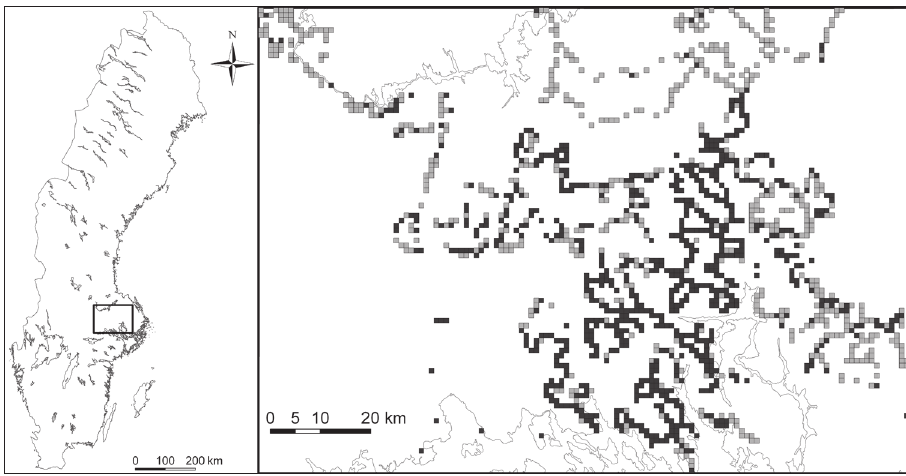
Figure 1. Survey area (mid-point 59°44'N, 16°52'E) in south-central Sweden covering 2554 km 2 . The 1 × 1 km grid squares (n = 874) show presence (black) and absence (grey) of Metrioptera roeselii